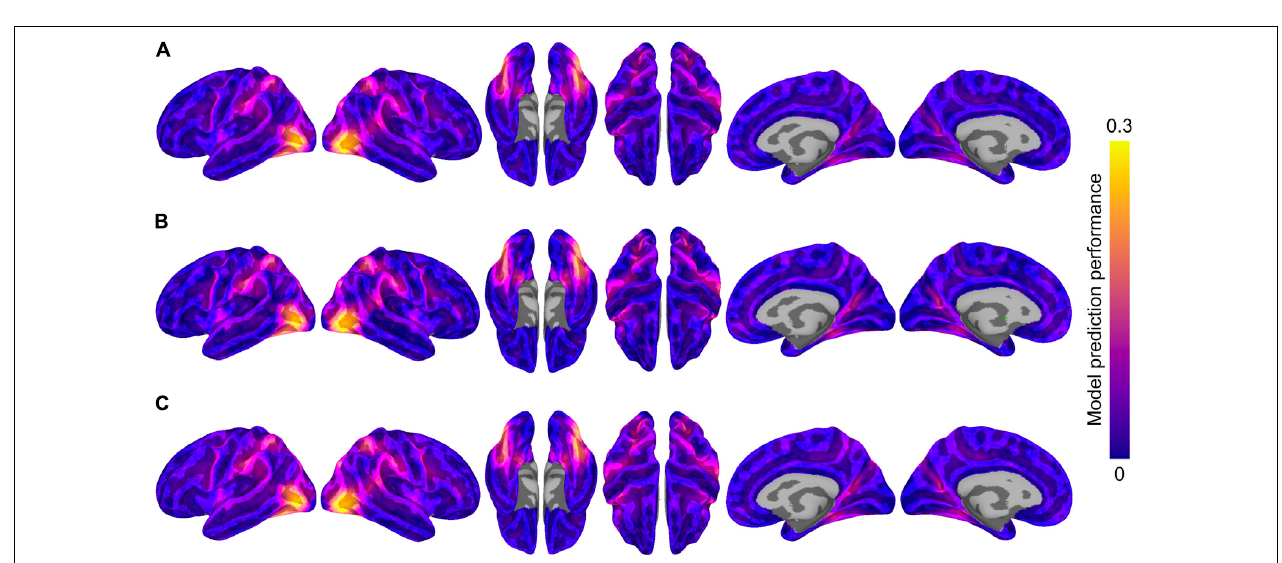
FIGURE 4 | Model prediction performance maps averaged across subjects. Colored vertices reflect the Pearson correlation between the predicted and actual time series averaged across the four test runs and averaged across subjects. Three types of models are presented: (A) within-subject model performance maps; (B) between-subject anatomically aligned model performance maps; and (C) between-subject hyperaligned model performance maps. Maximum correlations are 0.27 (in area LO, all three maps) and correlations at the 95% level for vertices within the mask ranged from 0.11 to 0.12. All maps are unthresholded and uncorrected for multiple